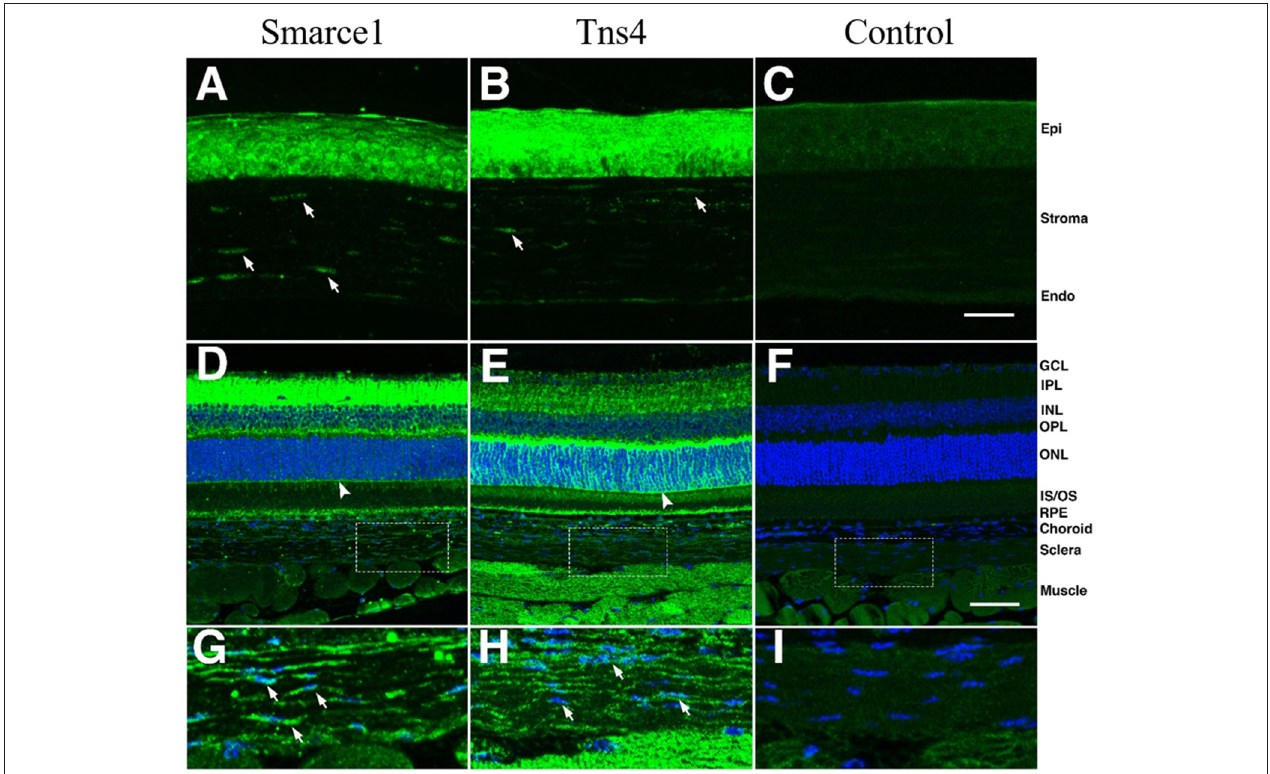
FIGURE 5 | Staining patterns for Smarce1 and Tns4 protein in the mouse eye. Sections through the mouse eye were stained for Smarce1 (A,D,G) and Tns4 (B,E,H) , and the staining pattern was compared to similar sections stained with the secondary antibody only (C,F,I) . In the cornea (A–C) the epithelium and keratinocytes (arrows) were positive for Smarce1 (A) and Tns4 (B) . These structures were not stained in the secondary control. In the retina, both antibodies labeled cellular components, with positive staining of the external limiting membrane (arrowhead), suggesting that one cellular component recognized by the antibodies are Müller cells. In higher magnifications of the sclera (G–I) , staining of scleral keratinocytes can be observed (arrows) for both Smarce1 and Tns4 . The locations of the photographs of the sclera (G–I) are shown by boxes in (D–F) . The images in (A–C) are at the same magnification and the scale bar in (C) represents 25 µ m. The images in (D–F) are at the same magnification and the scale bar in (C) represents 50 µ m. The legend to the right indicates specific structures: corneal epithelium (Epi), corneal endothelium (Stroma, Endo), ganglion cell layer (GCL), inner plexiform layer (IPL), inner nuclear layer (INL), outer plexiform layer (OPL), outer nuclear layer (ONL), inner segments/outer segments (IS/OS), Choroid, Sclera, and